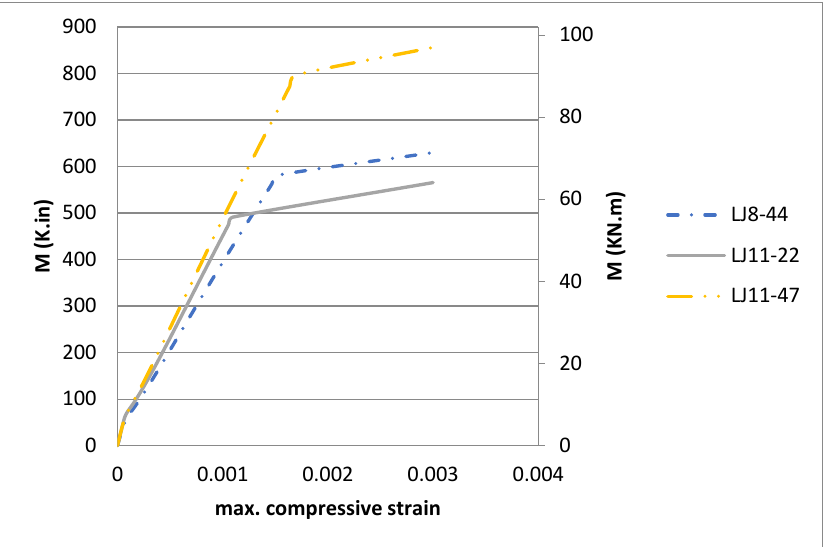
Figure 16. Ahmad and Batts (1991) [17] moment vs. curvature analytical graphs.